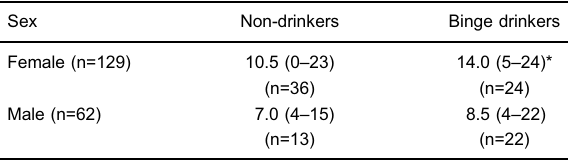
Table 1. Insomnia Severity Index (ISI) total scores in non-drinkers and binge drinkers by sex.